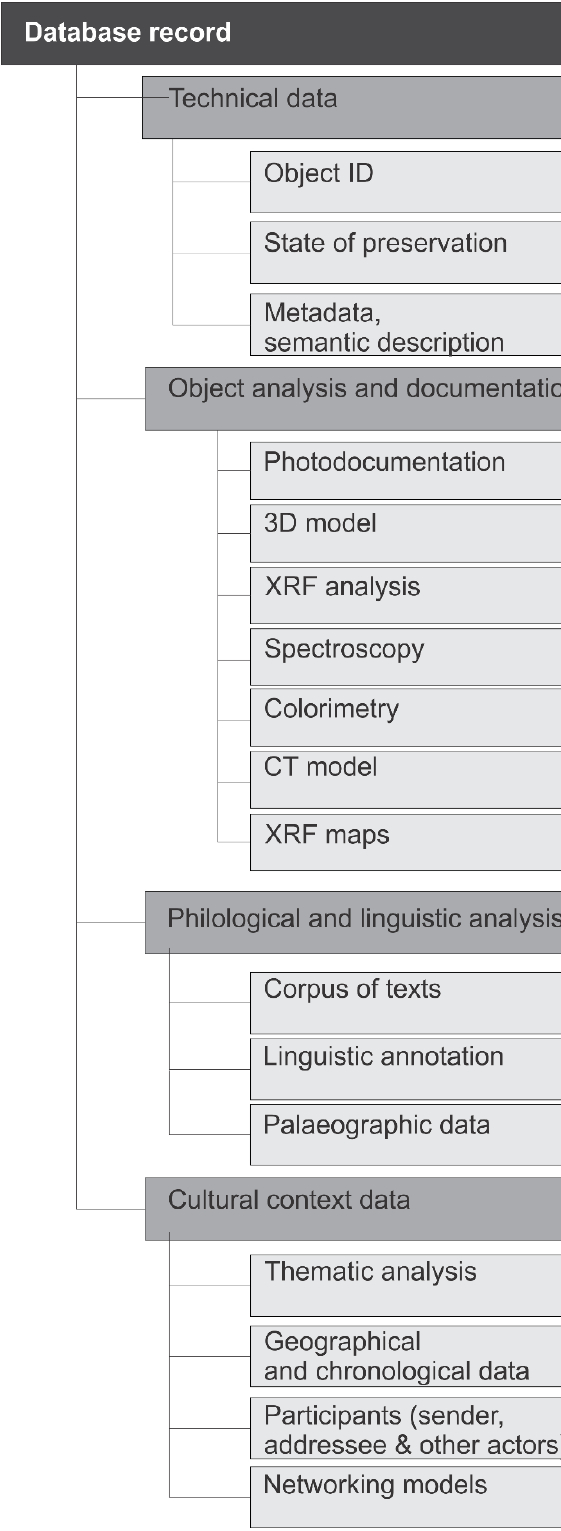
Figure 3. Detailed presentation of Prague’s cuneiform